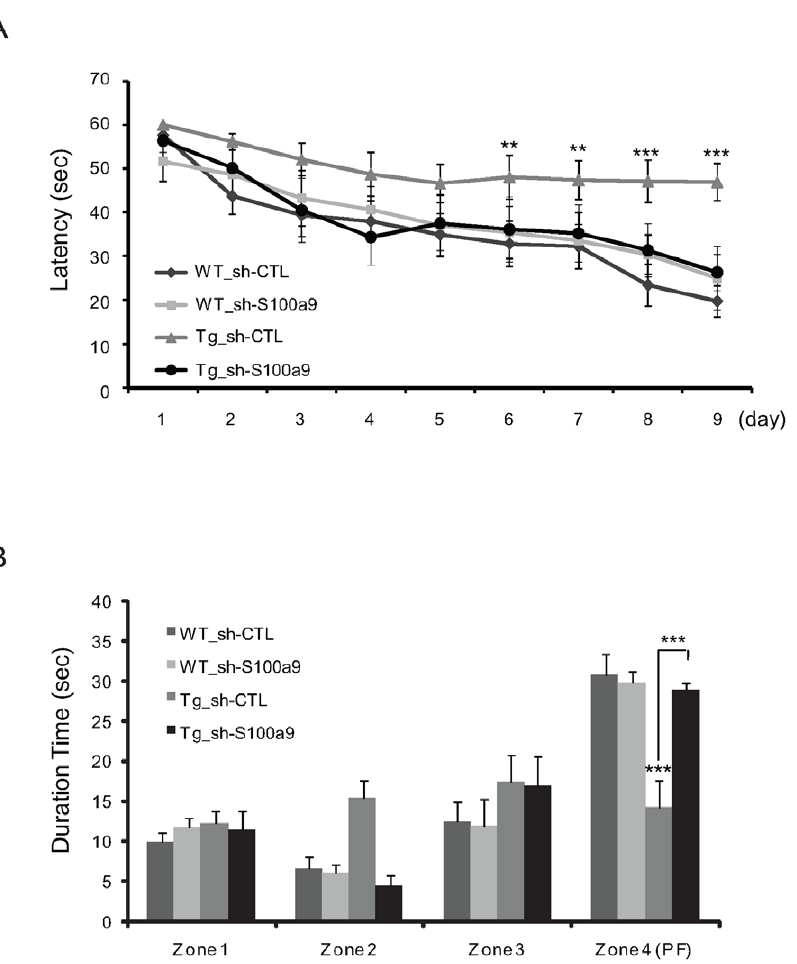
Figure 4. Treatment with shRNA-S100a9 attenuated learning and memory impairment in Tg2576 mice. (A) Morris water maze task was performed 2 months after lentiviral infection. The task was conducted for 9 consecutive days. A significant difference was observed between the Tg_sh-S100a9 group and the Tg_sh-CTL group from the 6 th day of the Morris water maze task. (B) The probe test was carried out 48 h after the final trial. Tg_sh-S100a9 group showed memory improvement compared to Tg_sh-CTL in zone 4 where the platform had been hidden (n=8 per group). **P , 0.01, ***P , 0.001 by one-way ANOVA.